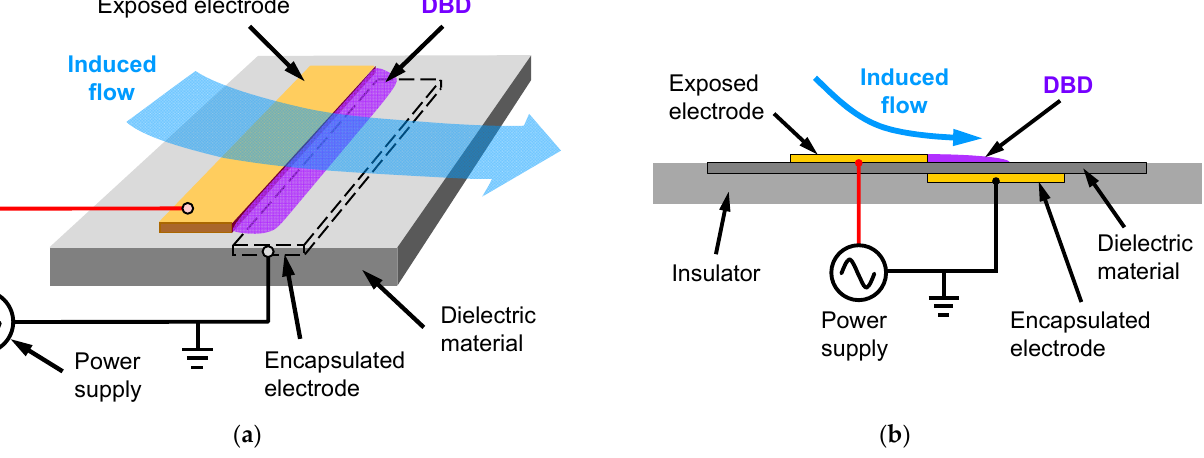
Figure 2. Schematic illustration of the DBD plasma actuator: ( a ) schematic of the plasma actuator; ( b ) cross section.